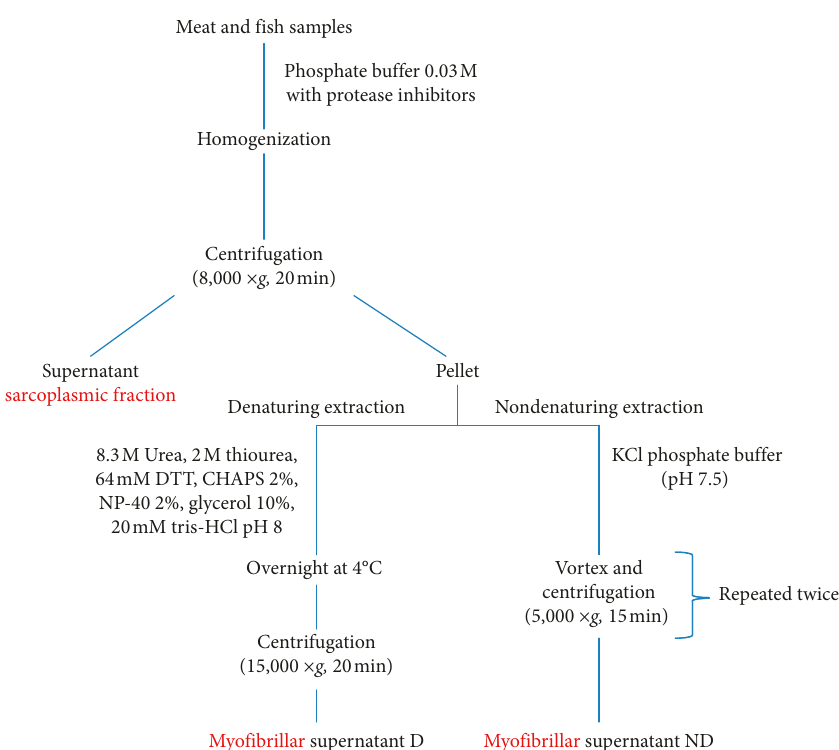
Figure 1: Flowchart of the extraction of sarcoplasmic and myofibrillar protein fractions from different